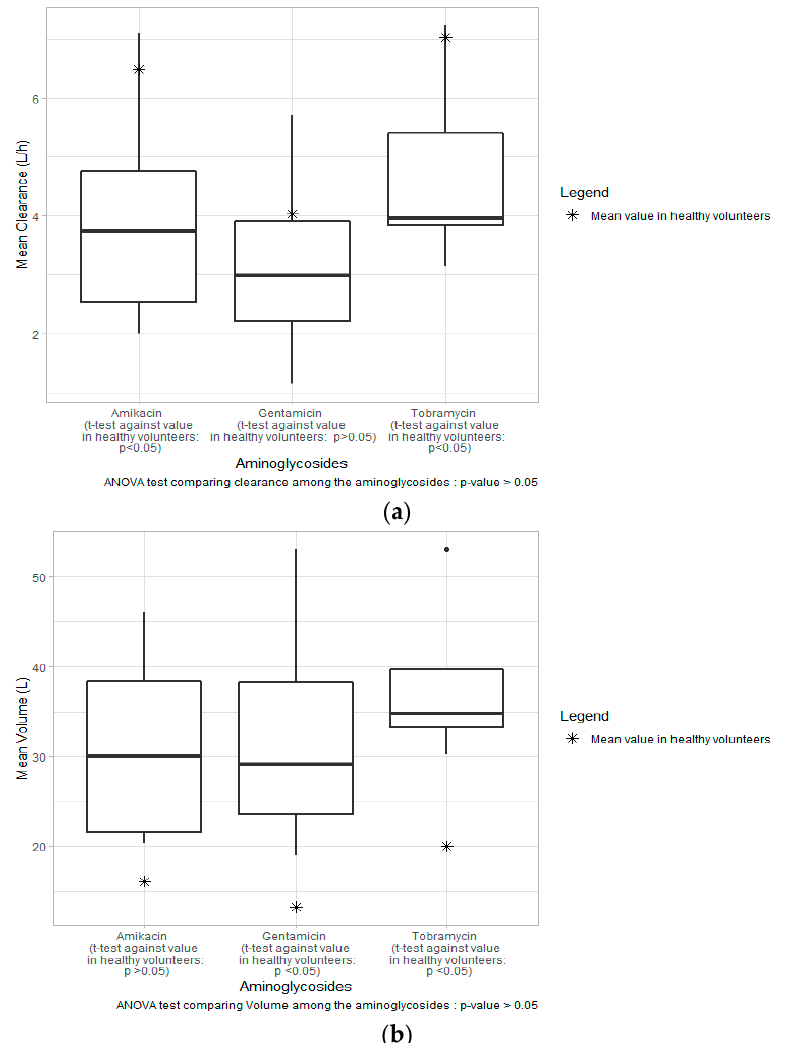
Figure 2. ( a ) Range of mean clearance across studies stratified by aminoglycosides (amikacin, gentamicin, and tobramycin) with mean clearance value in healthy volunteers (dotted line). ( b ) Range of mean volume of distribution across studies stratified by aminoglycosides (amikacin, gentamicin, and tobramycin) with mean volume of distribution value in healthy volunteers (dotted line).